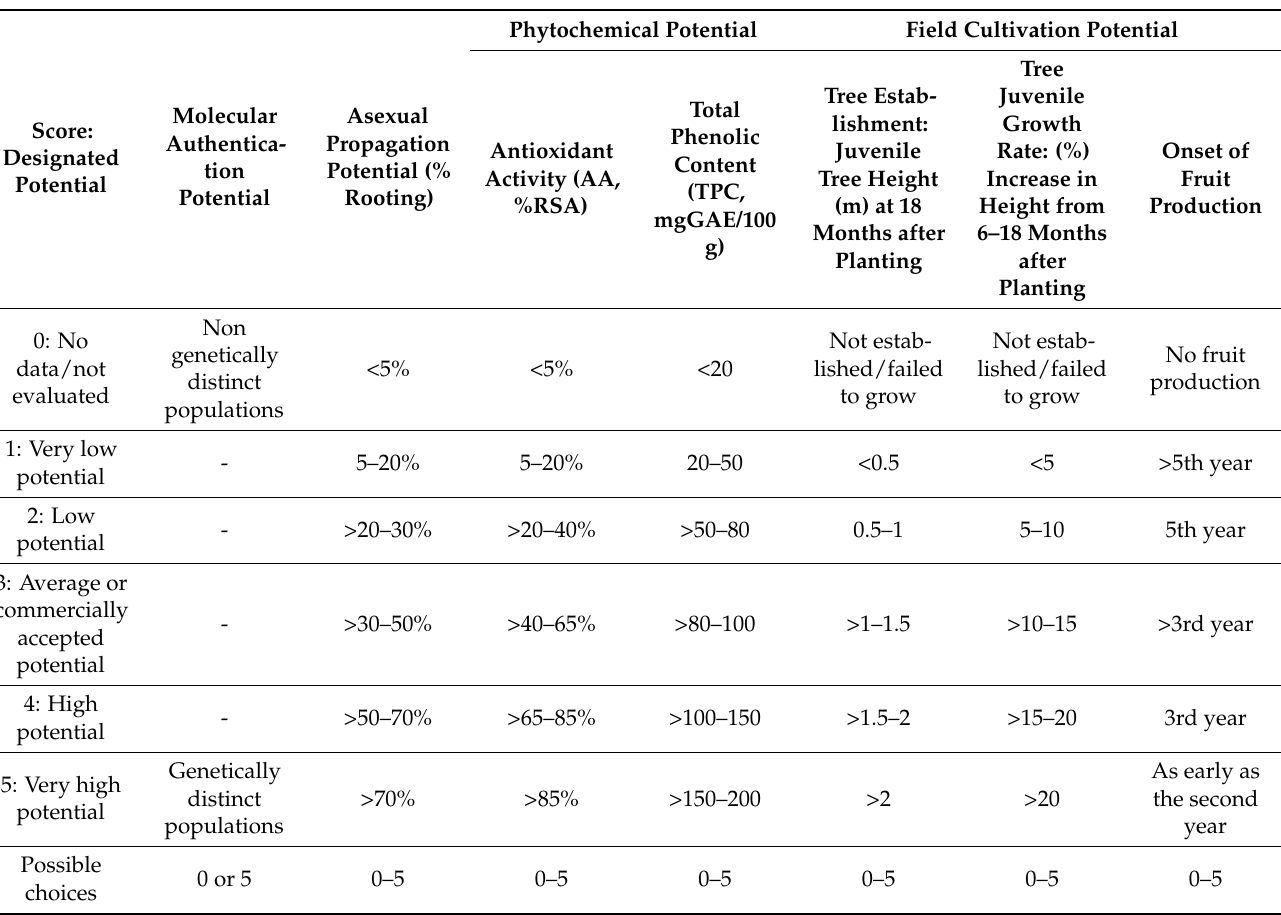
Table 4. The methodological scheme used to illustrate comparatively the multifaceted potential of the four Greek native species studied herein with the scoring of seven attributes in four evaluation axes (molecular authentication potential, phytochemical potential, asexual propagation potential, and ex situ cultivation potential) based on available respective data [12,24–26,48,49] and data furnished herein (see Table